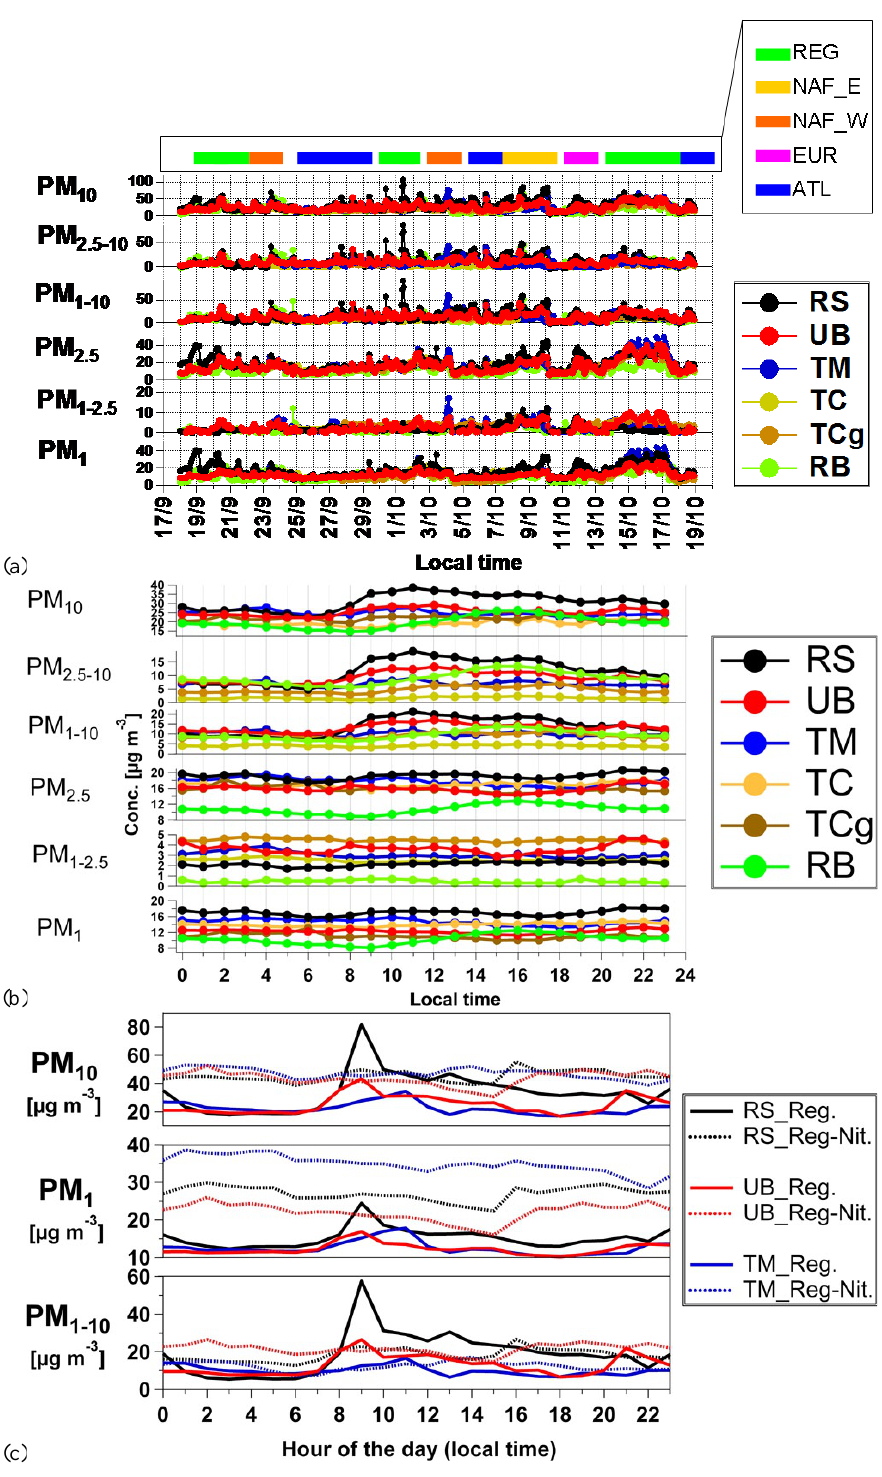
Fig. 11. Temporal trends (a) and diurnal variation of selected aerosol PMx mass (b) for all the SAPUSS studies. (c) represents selected case study periods: regional conditions (Reg: stagnant regional air masses without accumulation of nitrate containing aerosols, 29–30 September 2010) and regional conditions with nitrate (Reg-Nit: stagnant regional air masses with accumulation of nitrate containing aerosols, 15–16 October